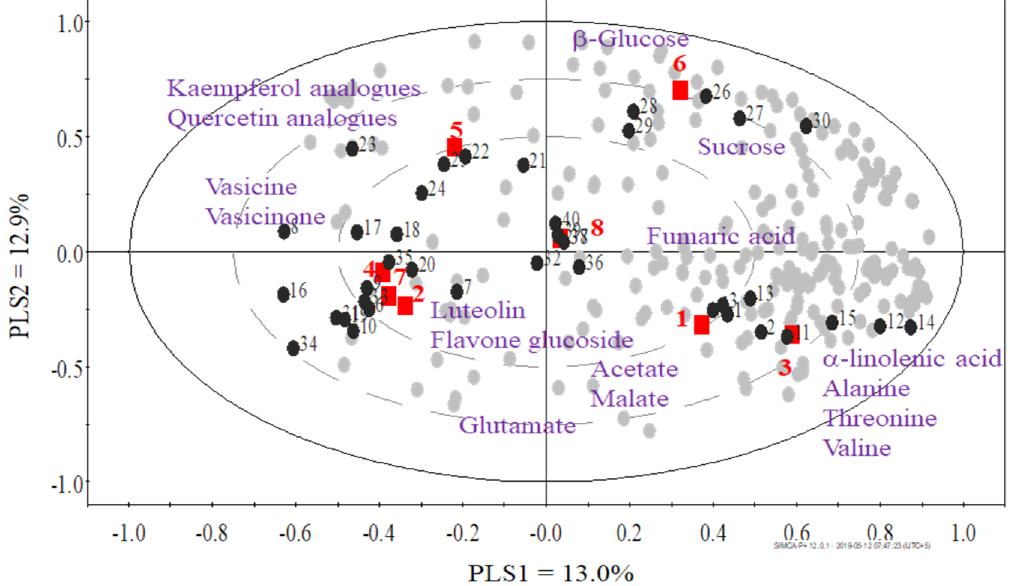
Figure 4. Principal Least Square Discriminant Analysis (PLS ‐ DA) (R2/Q2 = 0.356/0.003) of the NMR spectral data of Adhatoda vasica leaves. The grouping is based on different regions (i.e., Gazi = 1 ◼ , Haripur = 2 ◼ , Taxila = 3 ◼ , Khanpur = 4 ◼ , Rawaplindi = 5 ◼ , Havelian = 6 ◼ , Abbottabad = 7 ◼ and Muzaffarabad = 8 ◼ ) and numbering is based on latitude.